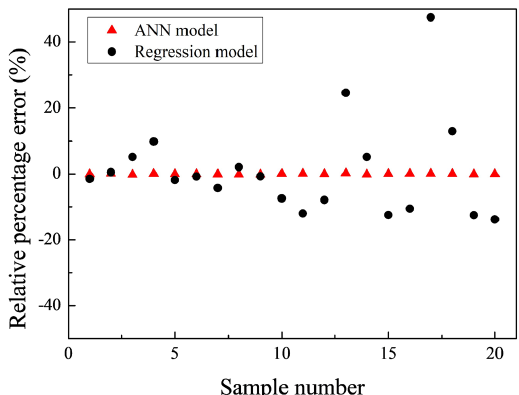
Figure 11. Comparison of relative percent error of predicted value by ANN and calculated value by regression model with experimental value at strain of